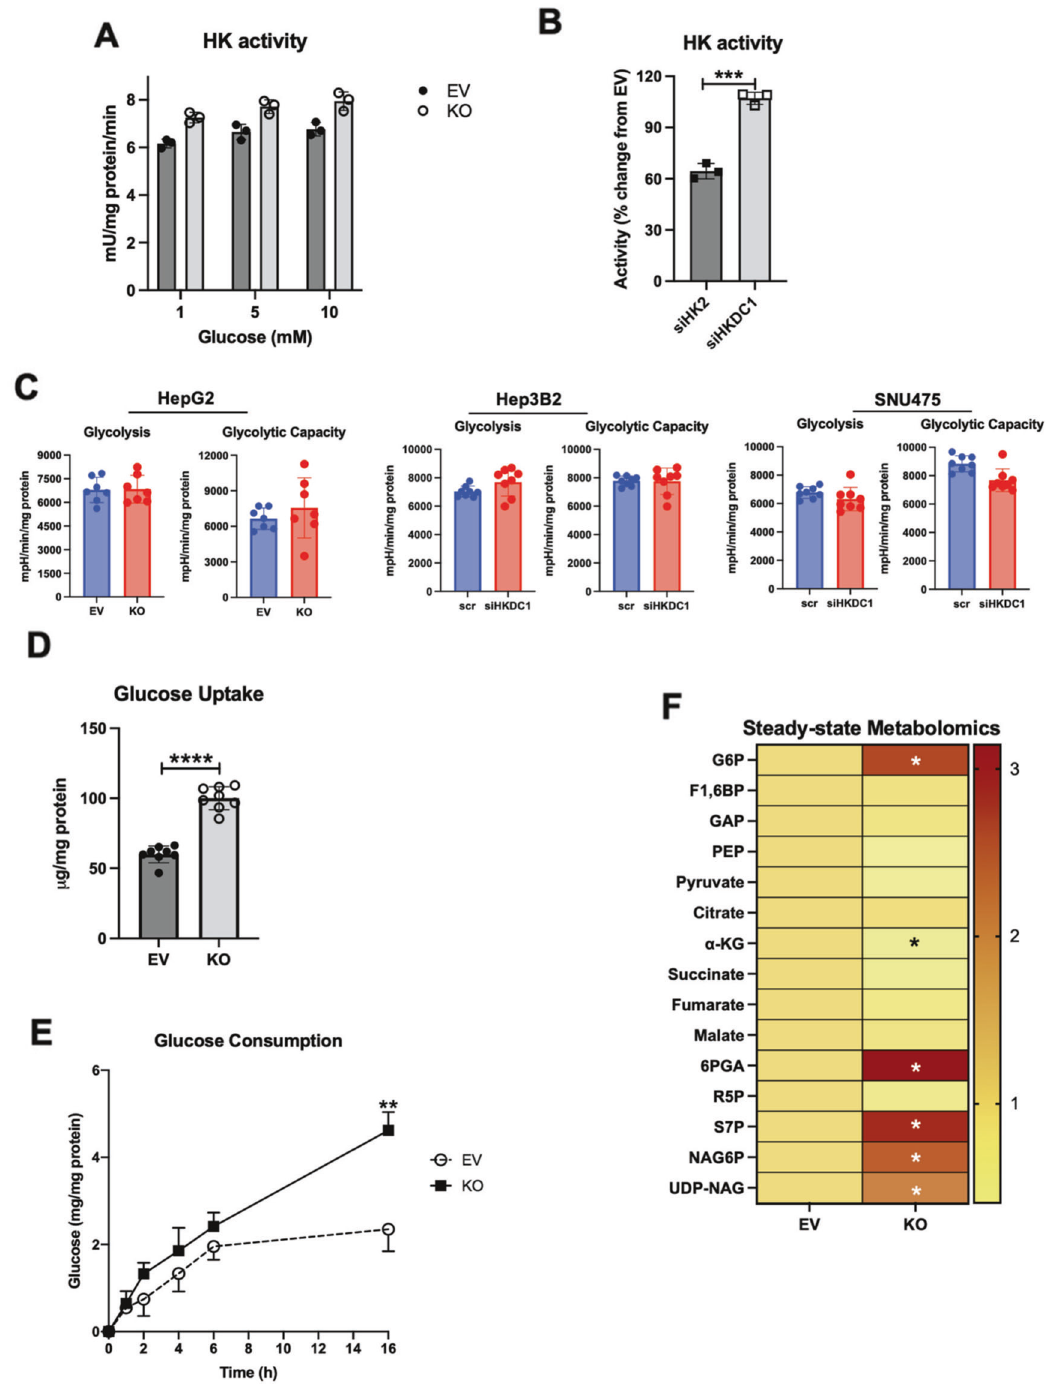
Fig. 4 HKDC1-KO impairs glucose metabolism. A Hexokinase activity in EV and KO HepG2 cells. B HepG2 cells were treated with siRNA against either HK2 or HKDC1 for 24 h, cells were lysed, and hexokinase activity was assayed. C Seahorse metabolic analysis (ECAR) of EV and HKDC1-KO cells (left panel) and siRNA-mediated HKDC1 knockdown (siHKDC1) in Hep3B2 and SNU475 cells (center and right panels). D 2-NBDG (2-(N-(7-Nitrobenz-2-oxa-1,3-diazol-4-yl)Amino)-2-Deoxyglucose) fl uorescent analog of glucose was used to assess glucose uptake in EV and KO HepG2 cells. E In EV and KO HepG2 cells, glucose consumption was assessed by measuring glucose concentration in media aliquots taken at designated time periods, which was subtracted from initial glucose concentration of media, obtaining glucose being consumed by the cells. F Steady-state metabolomics analysis of glycolytic and TCA cycle metabolites in cells cultured under standard growth condition ( n = 3, independent biological replicates). G Mass isotopomer analysis of glycolytic and TCA cycle metabolites in cells cultured with 5.5 mM of [U- 13 C 6 ] glucose and unlabeled glutamine ( n = 3, independent biological replicates) for 4 h. H Mass isotopomer analysis of TCA cycle metabolites in cells cultured with 2 mM of [U- 13 C 5 ] glutamine and unlabeled glucose ( n = 3, independent biological replicates) for 4 h. I Schematic summarizing the changes in glucose fl ux upon HKDC1-KO. Exp A – D were performed 2 – 3 independent times, with three replicates per individual experiment. Values are ± SD; * p < 0.05; ** p < 0.01; *** p < 0.001; **** p < 0.0001 by Student ’ s t -test (for A – C ) or two-way ANOVA (for D – F ). Cell Death and Disease (2022)